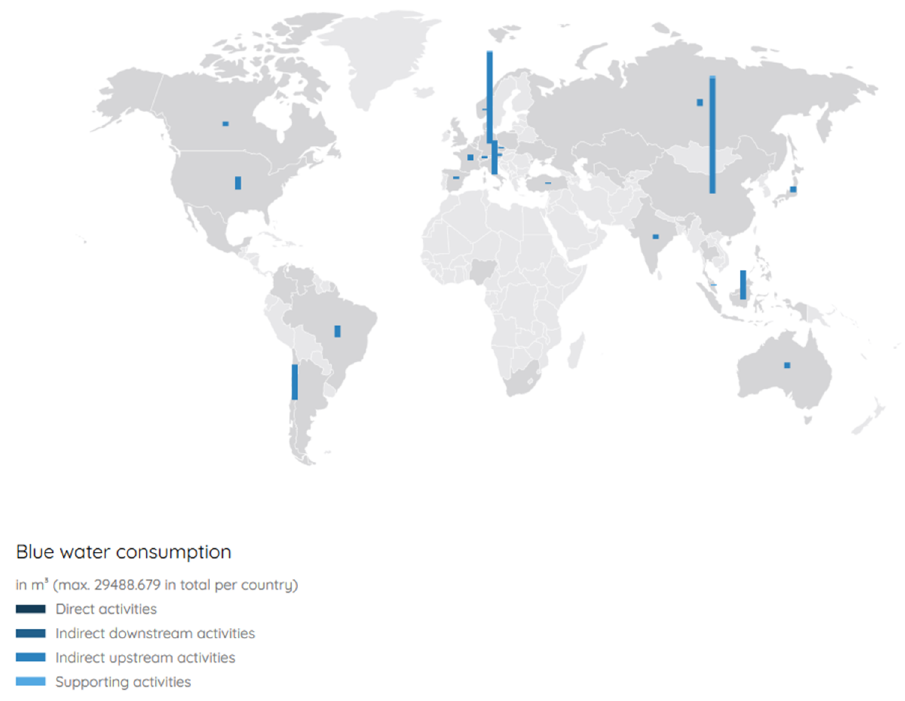
Figure 4. Total freshwater consumption by country/location. Screenshot from http://wf-tools.see.tu-berlin.de/wf-tools/owf/#/calculation.